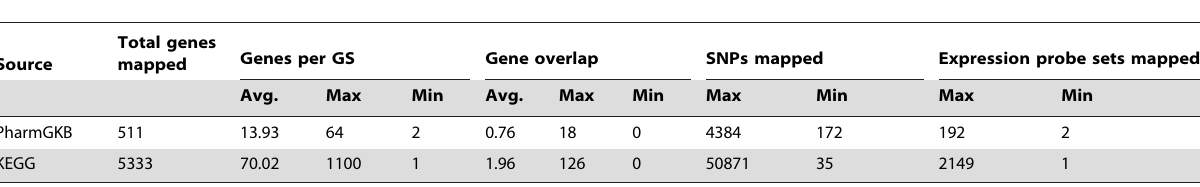
Table 1. Summary of gene expression and SNP GS mappings for PharmGKB and KEGG.